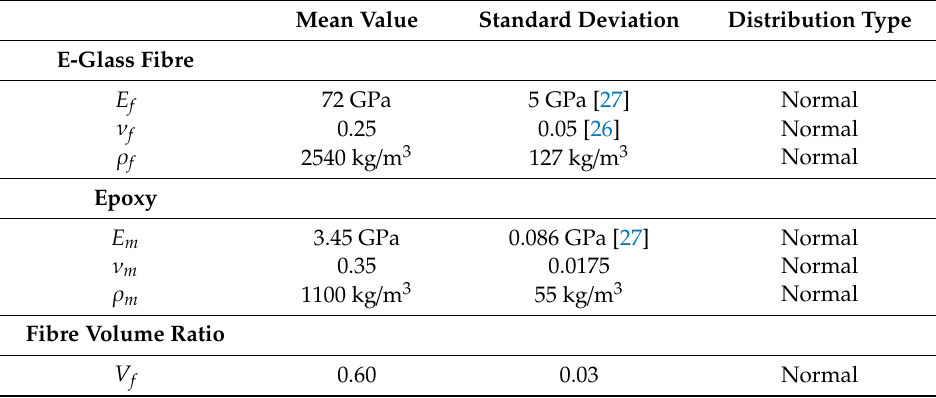
Table 1. Statistics of properties of fibre and